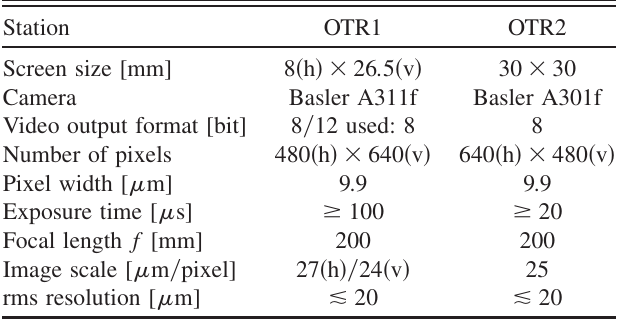
TIME-RESOLVED ELECTRON BEAM PHASE SPACE . . TABLE I. Properties of the stations OTR1 and OTR2 [14,15]. Abbreviations: horizontal (h), vertical (v).